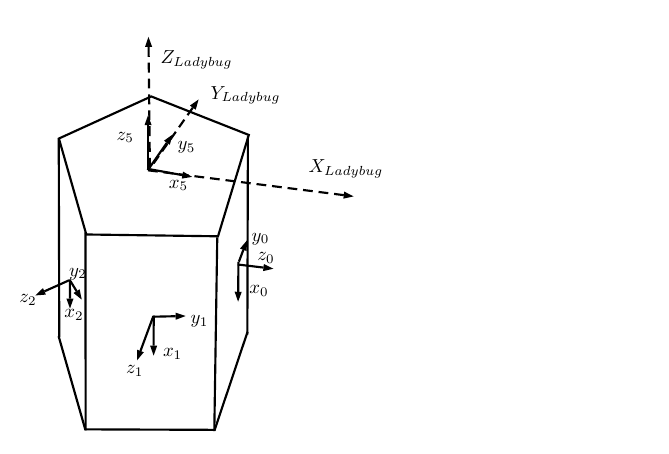
Figure 11. The relationship between cameras and the global coordinate